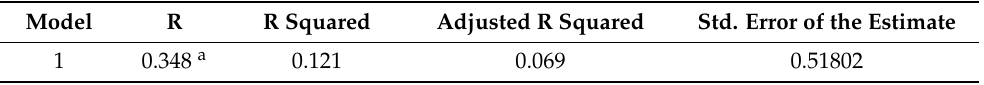
Table 11. Multiple regression: patient misidentification consequences and HIS components.